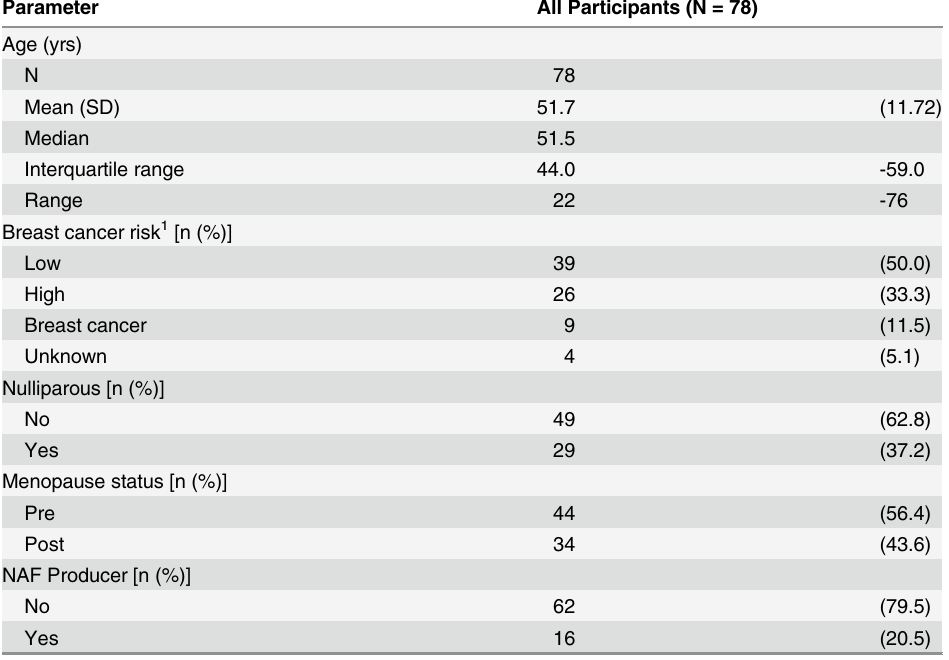
Table 1. Study Participant